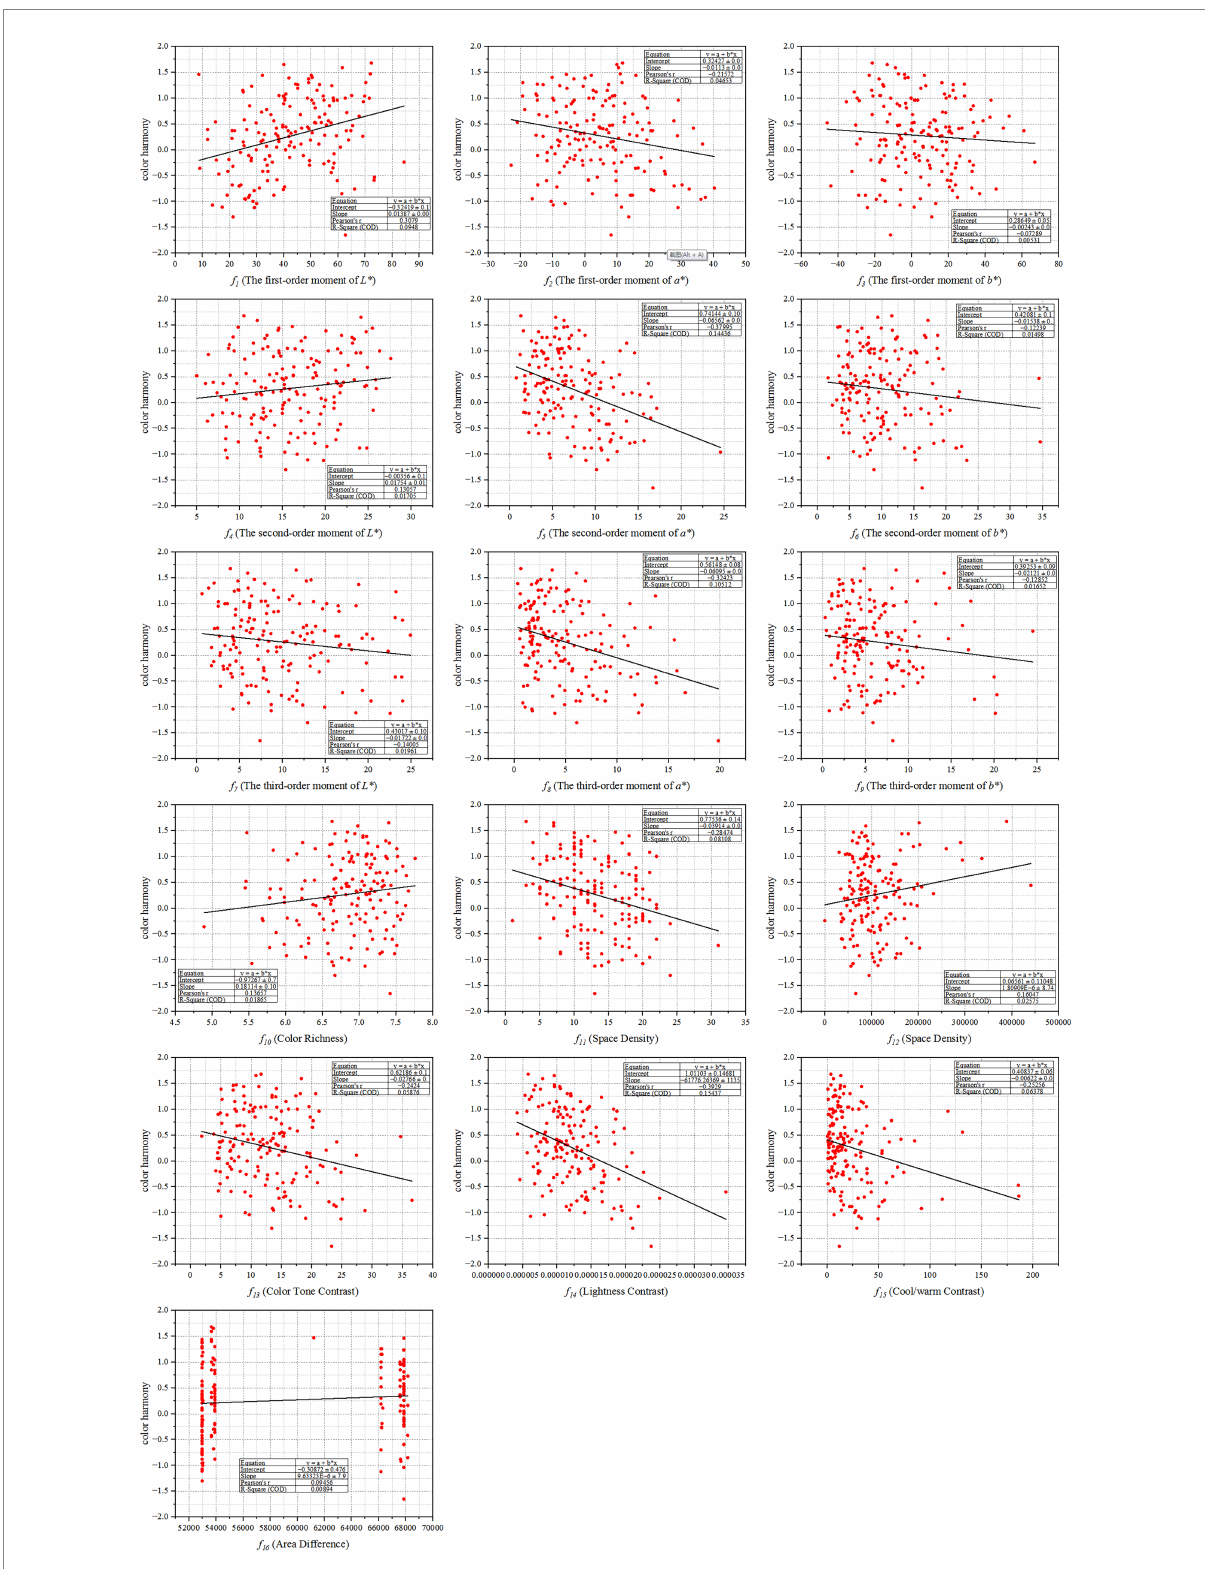
FIGURE 6 The scatter plots between multi-color physical features and color harmony. Among them, X -axis represents each multi-color physical feature, and Y -axis represents the corresponding value of the degree of color